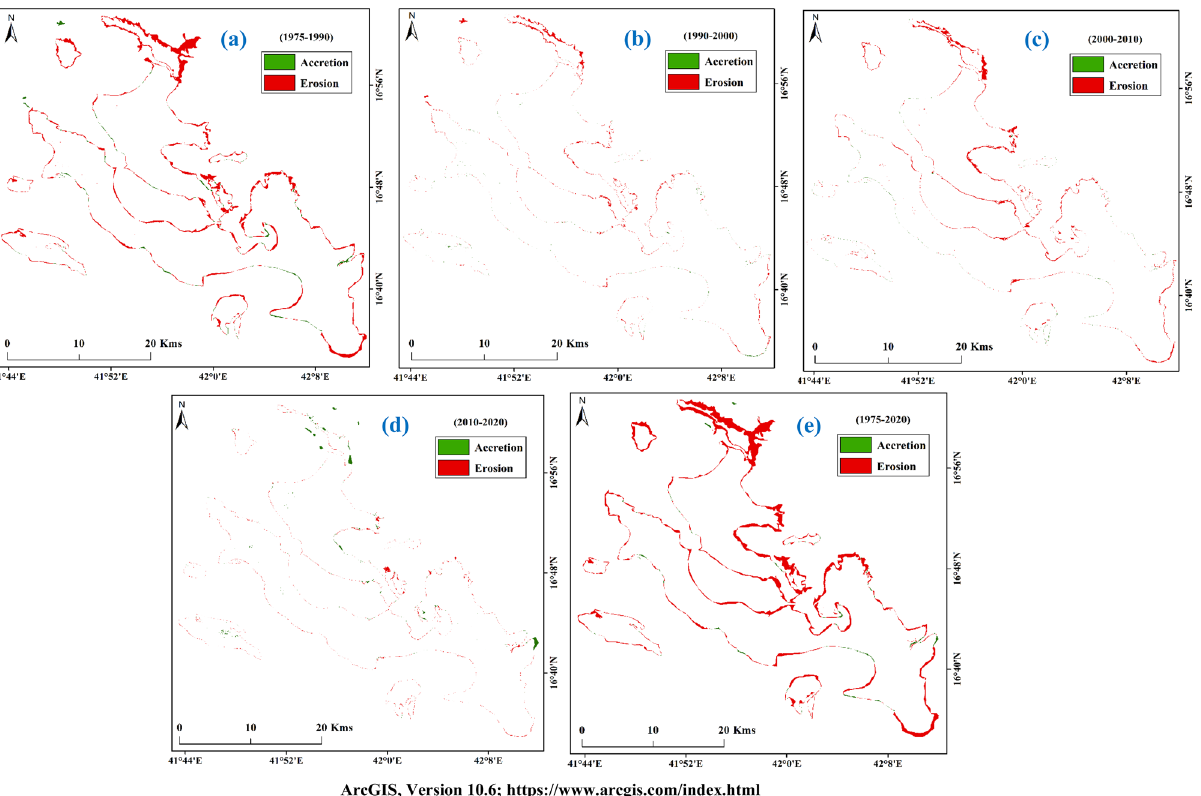
Figure 11. Erosion and accretion in Farasan Islands; ( a ) 1975–1990; ( b ) 1990–2000; ( c ) 2000–2010; ( d ) 2010–2020; and ( e ) 1975–2020 31,64 . The satellite data was downloaded from USGS earth explorer (https://